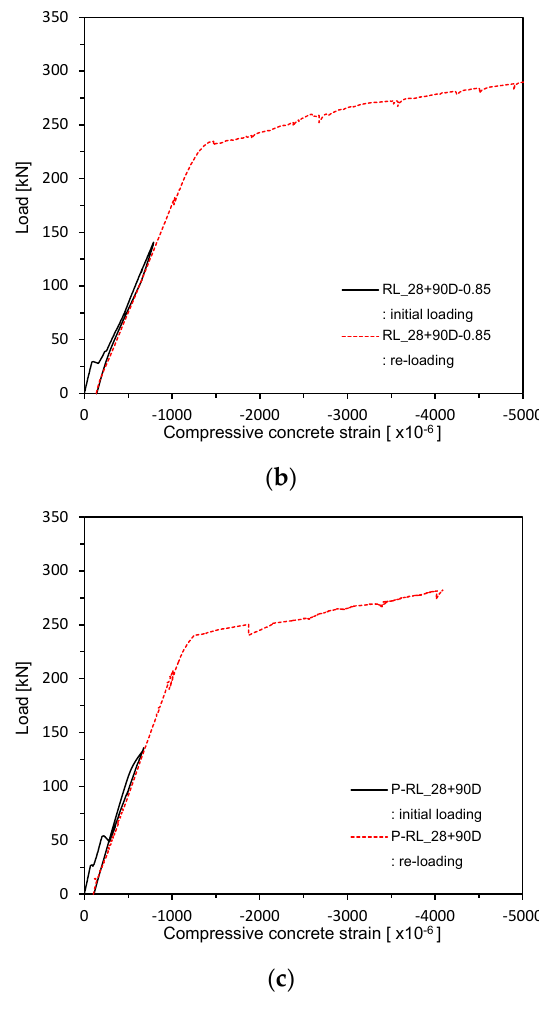
Figure 20. Load–concrete strain measurement after 28 + 90 days (up to ultimate load after pre-loading and additional 90 days of curing after pre-loading): ( a ) 2.5 series; ( b ) 0.85 series; ( c ) Plain series.